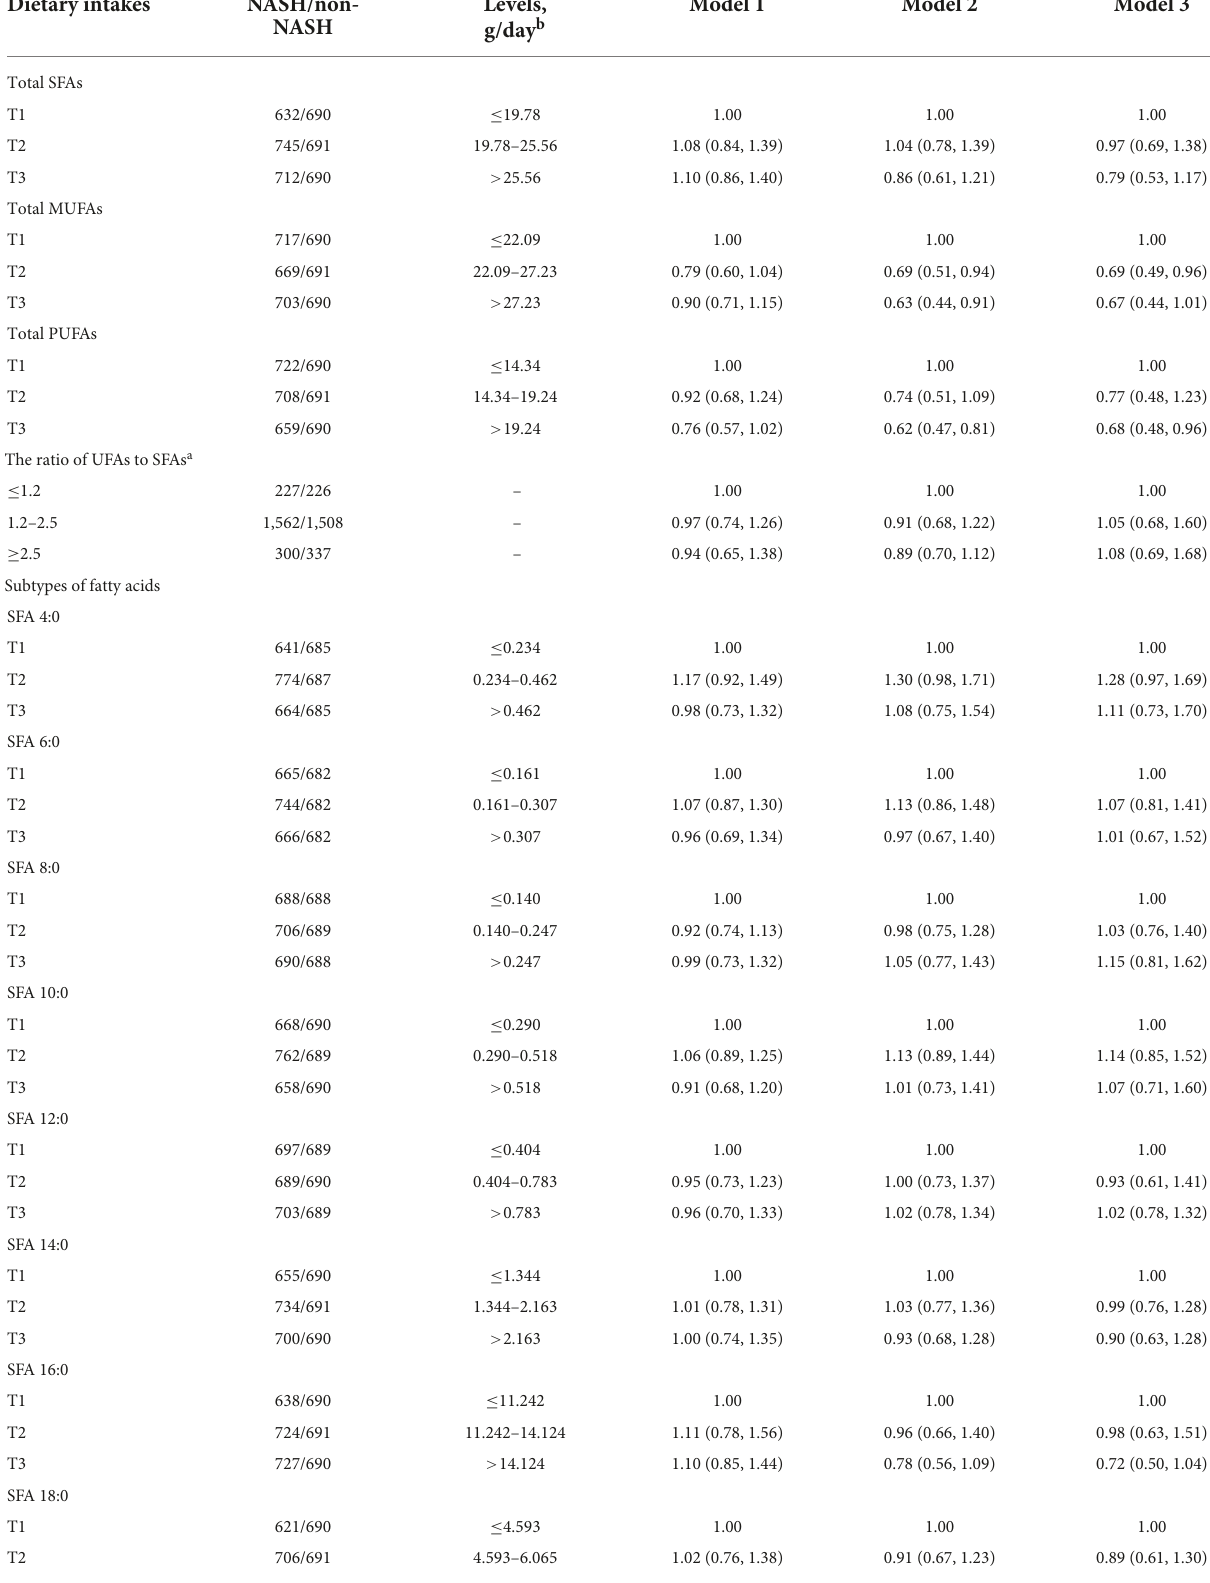
TABLE 3 Odds ratios (ORs) and 95% confidence intervals (CIs) of non-alcoholic steatohepatitis by terciles of dietary intakes of fatty acids among controls ( n = 4,161). Dietary intakes NASH/non-